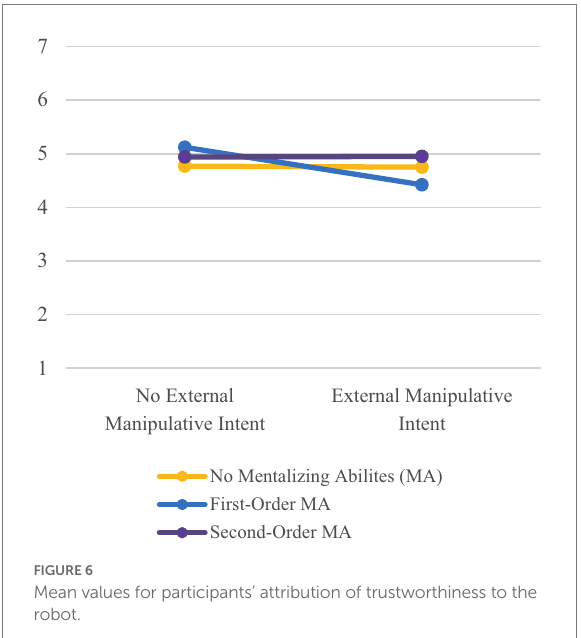
FIGURE 6 Mean values for participants’ attribution of trustworthiness to the robot.